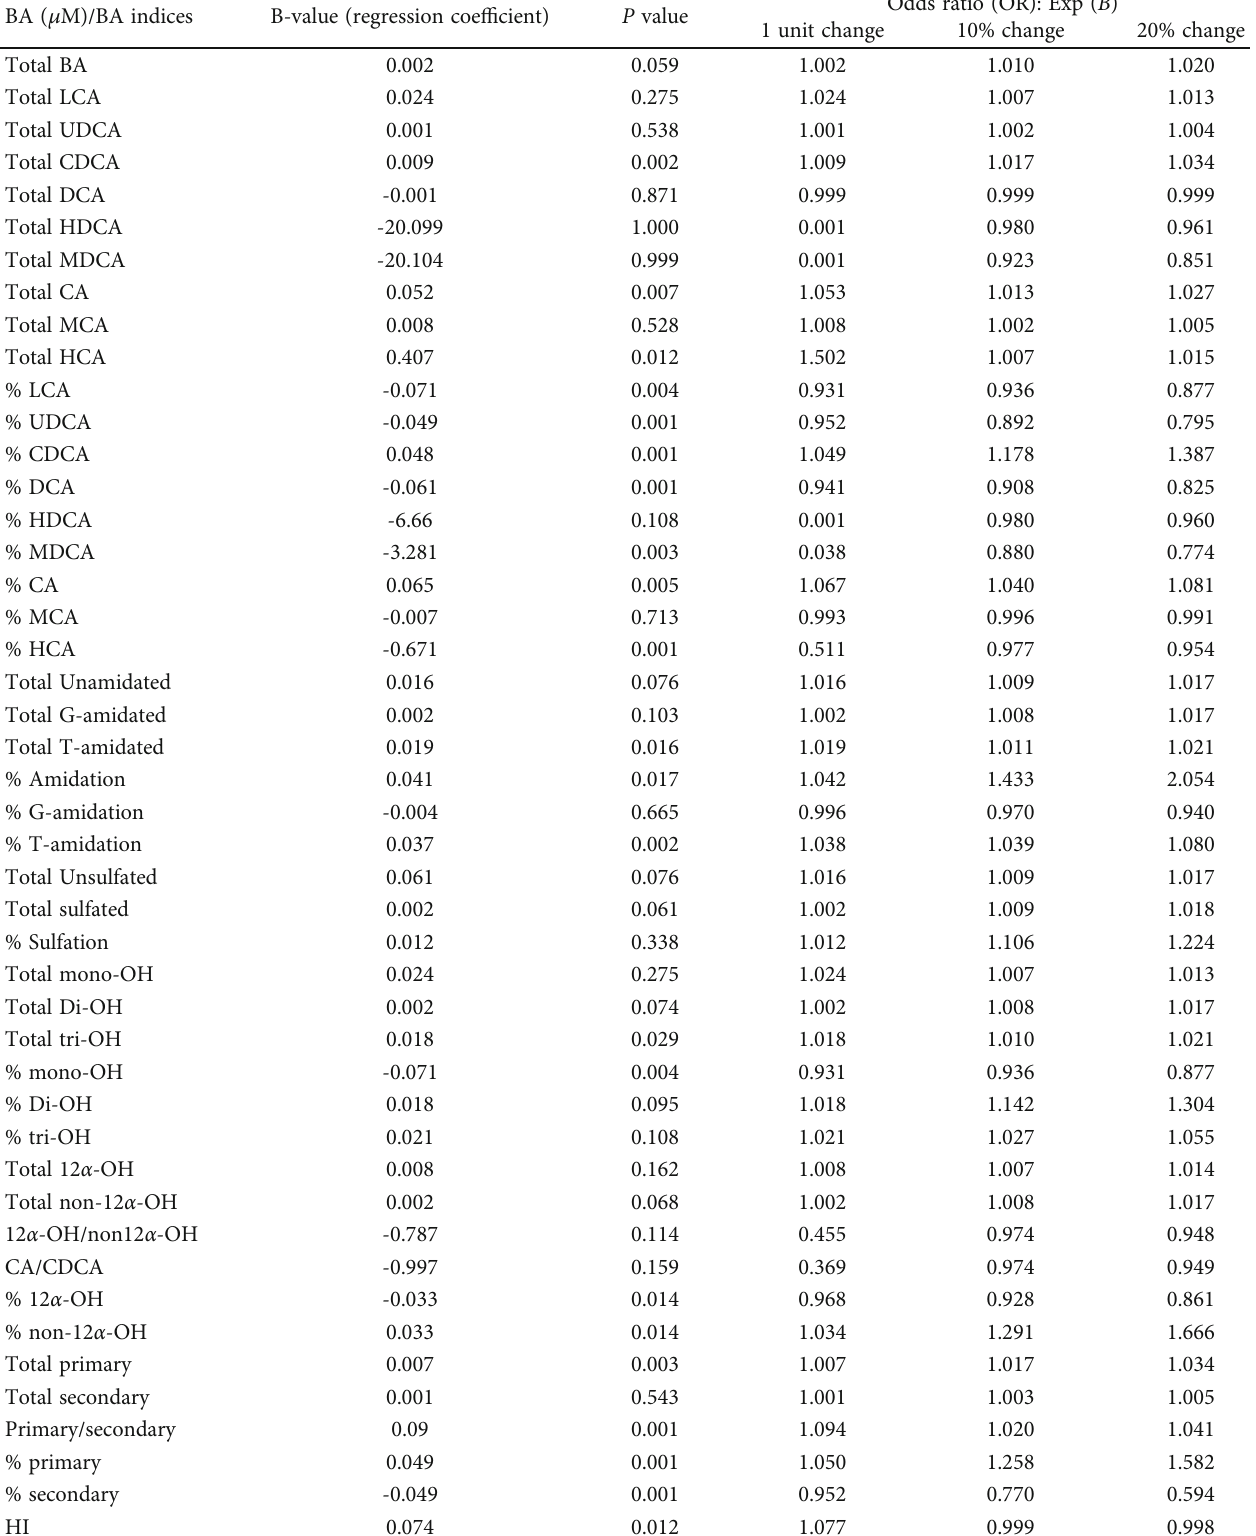
Table 3: Univariate logistic regression analyses for the prediction of developing ascites in the entire liver-patient population based on BA